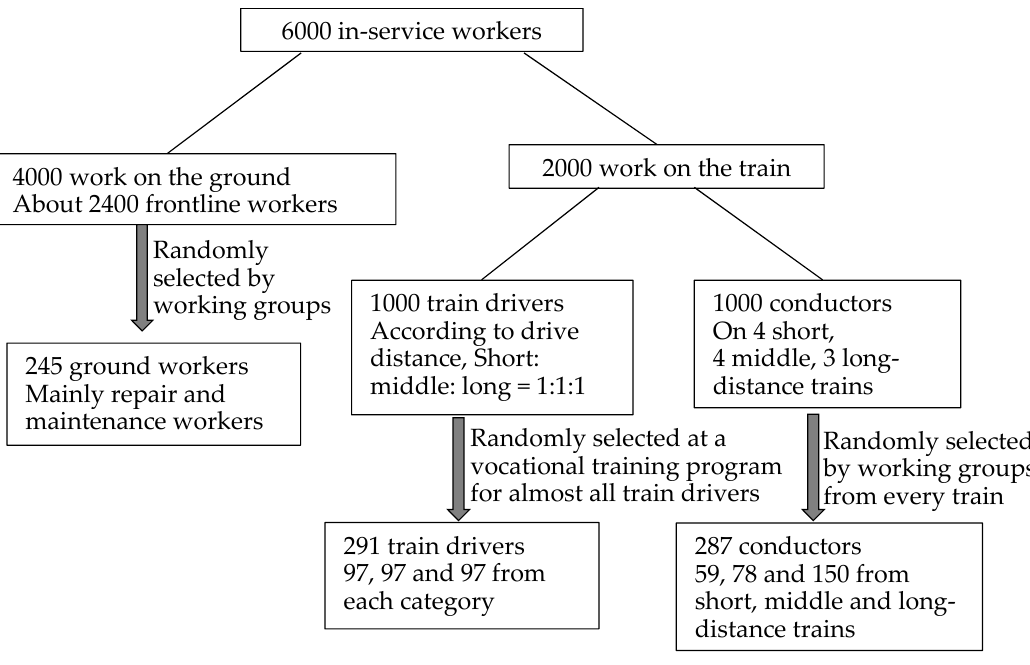
Figure 1. The sample selection process.